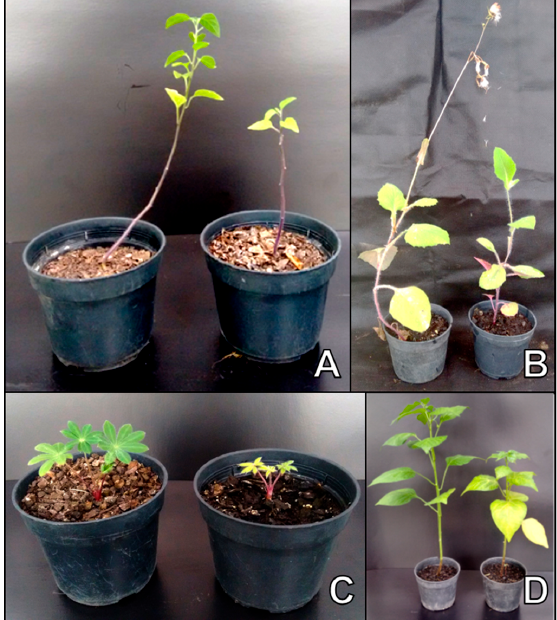
Figure 3. Amaranthus viridis ( A ), Emilia sagittata ( B ), Lupinus polyphyllus ( C ) and Mirabilis jalapa ( D ) showing dwarfism 60 days after inoculations with a Brazilian chrysanthemum stunt viroid (CSVd) isolate. The non-inoculated (healthy) controls are shown in each photo on the left.